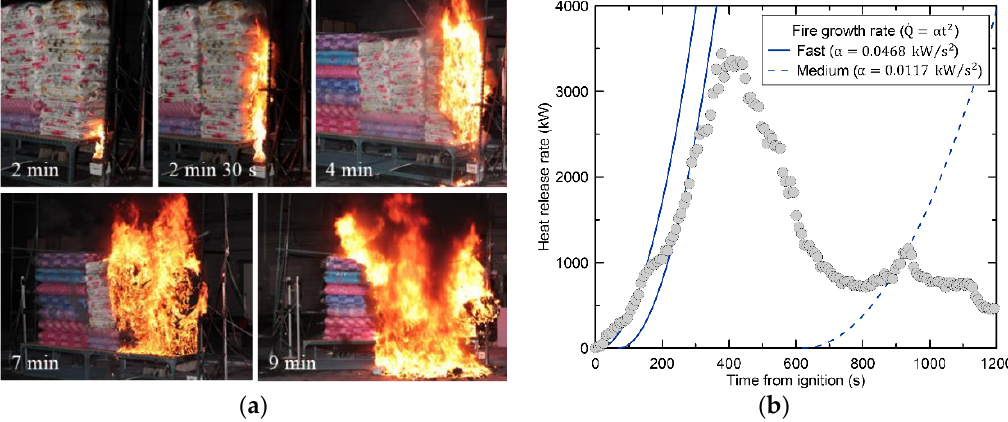
Figure 7. Fire spread pattern and heat release rate of blankets placed on stalls: ( a ) Sequential photographs of fire spread over time; ( b ) measured heat release rate.